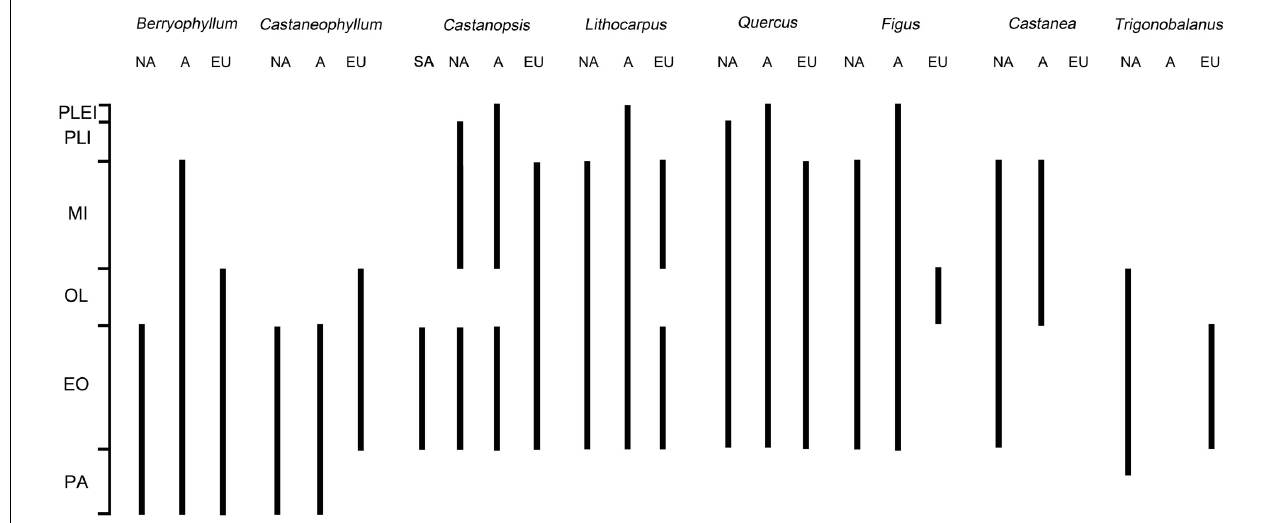
FIGURE 1 | Fossil records of Fagaceae in the Cenozoic. PA, Paleocene; EO, Eocene; OL, Oligocene; MI, Miocene; PLI, Pliocene; PLEI, Pleistocene; SA, South America; NA, North America; A, Asia; EU, Europe. References for the fossil records are listed in S1 ( Supplementary Material ).